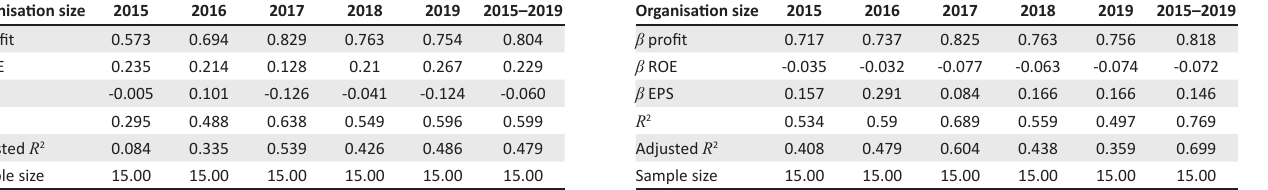
TABLE 5: Multiple regression – Organisation performance on chief executive officers’ variable remuneration. Organisation size